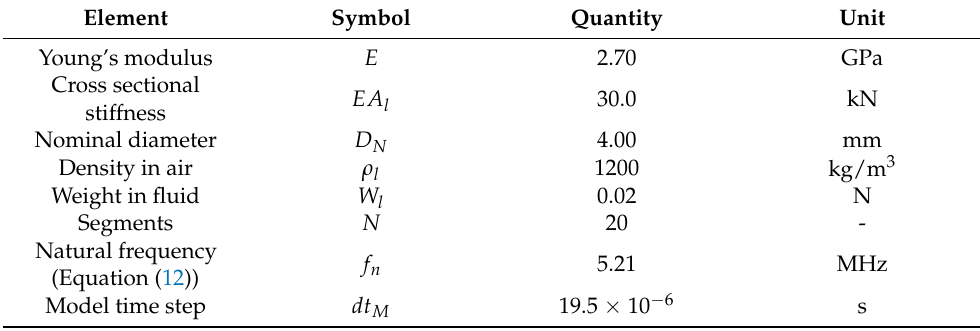
Table 1. Definition of the mooring line input parameters and the internal numerical